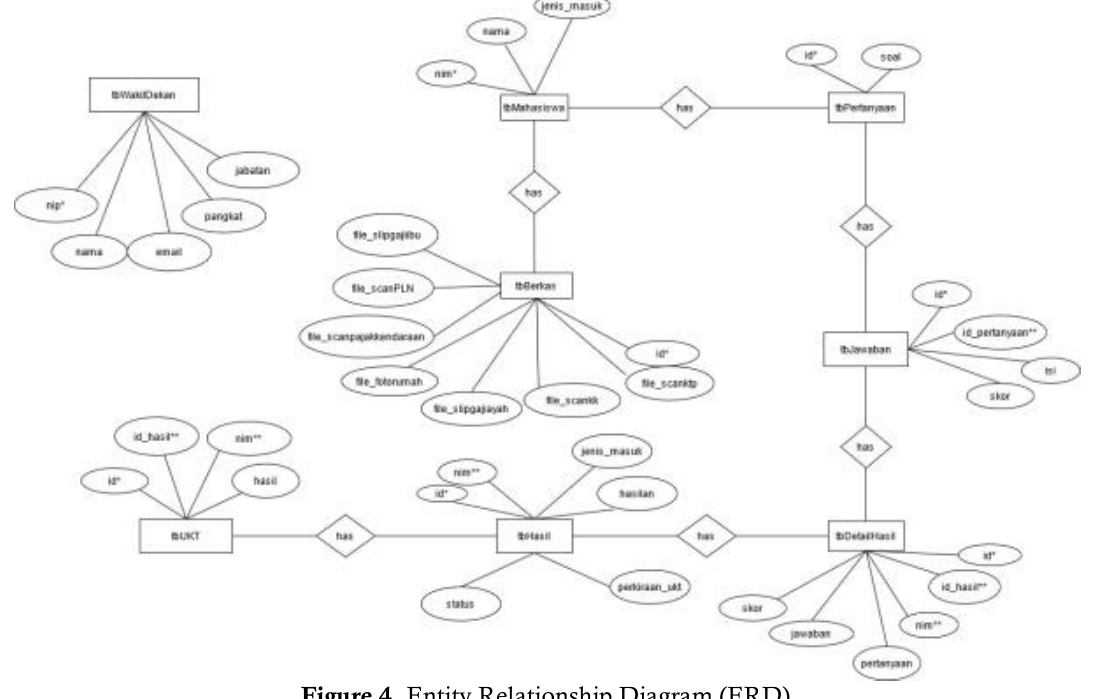
Figure 4. Entity Relationship Diagram